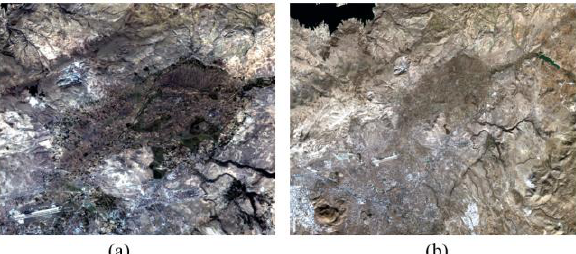
Figure 6: (a) Rasat RGB Image, (b) Landsat-8 RGB Image.